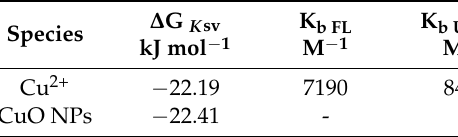
Figure 8. ( Top ): Plots of the intensities of the fluorescence spectra of H 3 L (10 − 4 M) vs. [CuO NPs] in an 80:20 ethanol:water solution. Slopes of the curves at 293, 303, and 313 K are Stern-Volmer constants K SV ( K SV = k q τ , where τ is the lifetime of the fluorophore) at the cited temperatures. ( Bottom ): The Scatchard plot for binding H 3 L to CuO NPs at 293, 303, and 313 K and pH 11. Table 5. Values of Gibbs free energy, binding constant, and quenching constant for the reaction of H 3 L with Cu 2+ ions (in 1:1 molar ratio), as well as CuO NPs. Binding constants were obtained from fluorescence emission intensity and UV-Vis